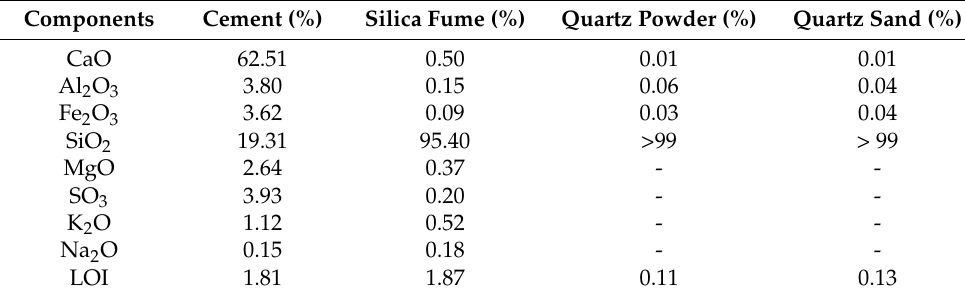
Table 1. Chemical properties of raw materials used for manufacturing UHPC.